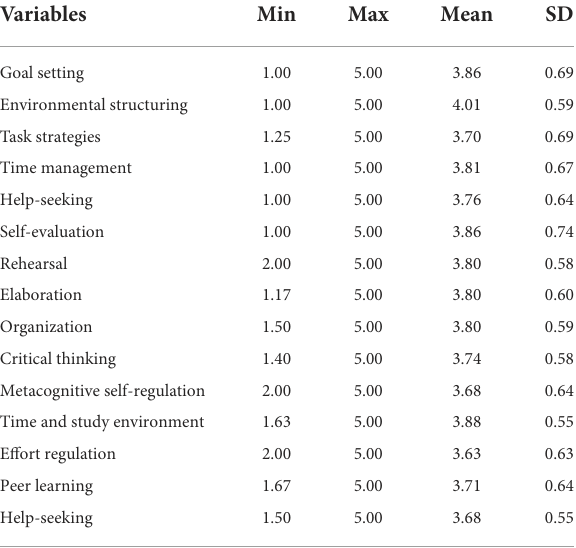
TABLE 2 Descriptive statistics of online learning